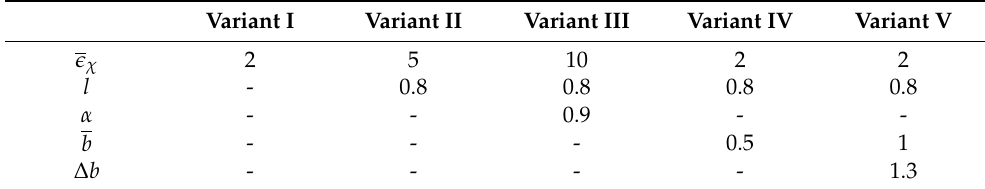
Table 1. Values of parameters used to calculate the optimal weighting factor (cid:101) χ ; indicator q , simulation scenario Cloud 1 .